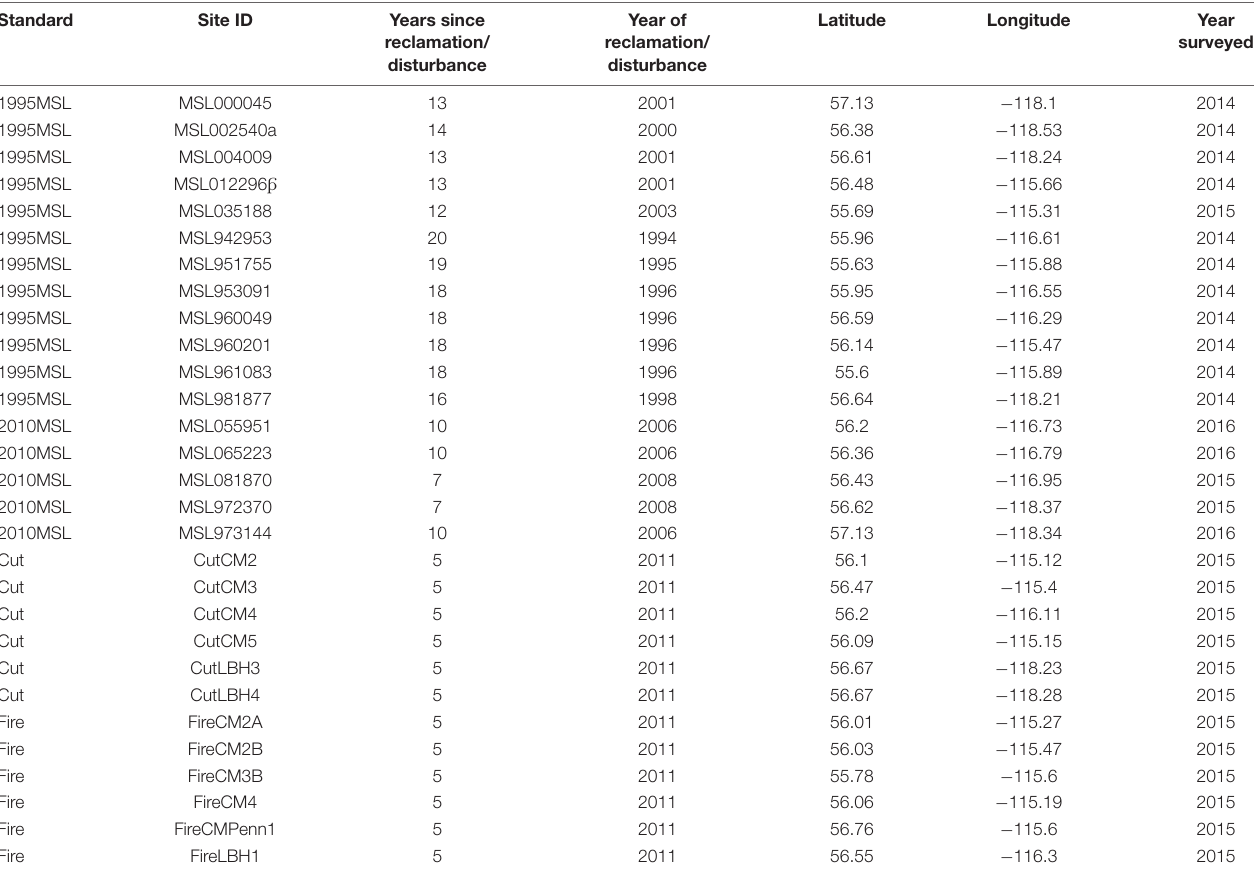
TABLE 2 | Site information for all test sites across North-Central Alberta,